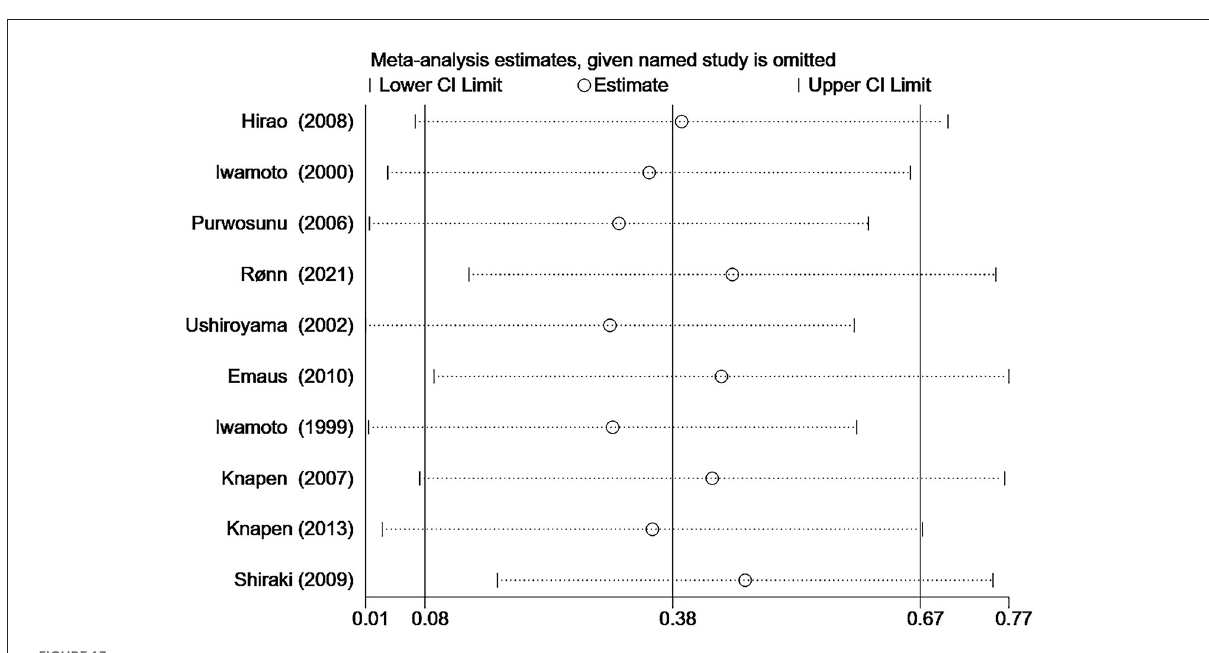
FIGURE13 Sensitive analysis for the overall effect test of BMD LS